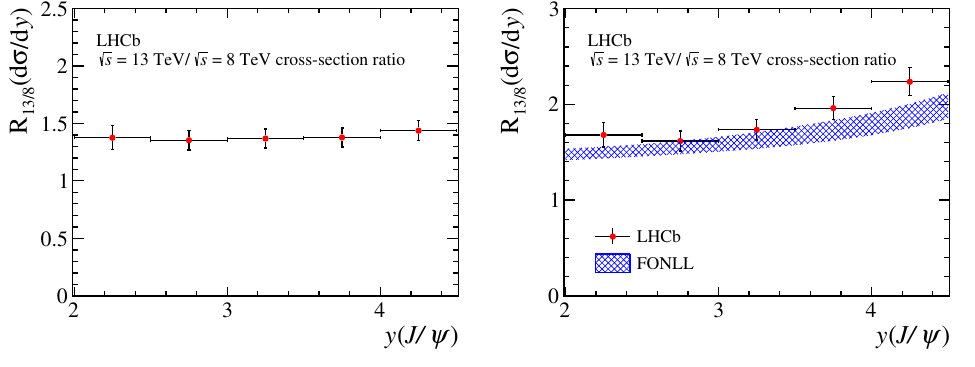
p p s = 13 TeV and s =